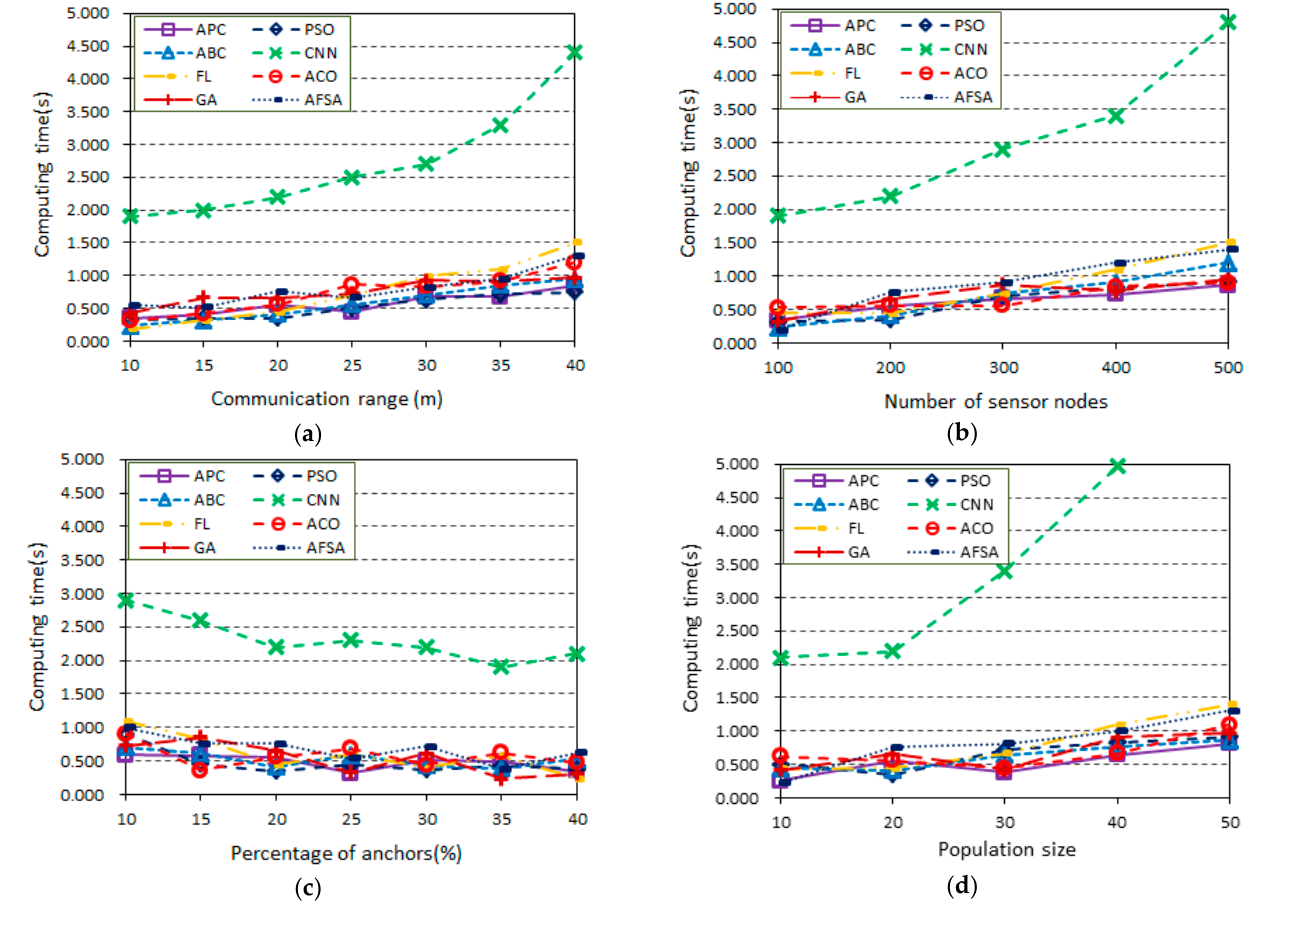
Figure 6. Algorithm comparison in relation to computing time. ( a ) Communication range vs. positioning accuracy (200 sensor nodes, 20% anchor nodes, population size m = 20); ( b ) the total number of sensor nodes vs. positioning accuracy (communication range r = 20 m, 20% anchor nodes, population size m = 20); ( c ) percentage of anchor nodes vs. positioning accuracy (communication range r = 20 m, 200 sensor nodes, population size m = 20); ( d ) population size vs. positioning accuracy (communication range r = 20 m, 200 sensor nodes, 20% anchor nodes).